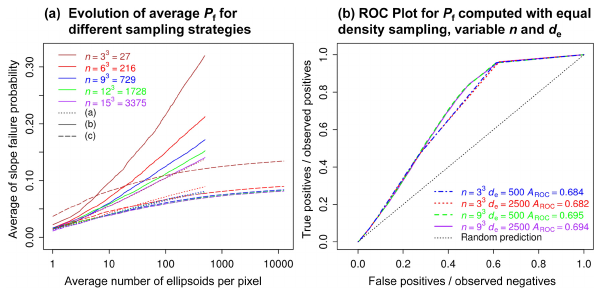
Figure 7. Slope failure probability computed with r.slope.stability. (a) Evolution of P f for a subset of the Collazzone study area (see Fig. 4) with increasing value of d e . The outcomes of the sam- pling strategies (a), (b) and (c) introduced in Fig. 2 are compared. (b) ROC plot relating P f obtained with equal density sampling (strategy c) to the observed shallow landslide areas in the entire Collazzone study area for different values of n and d e